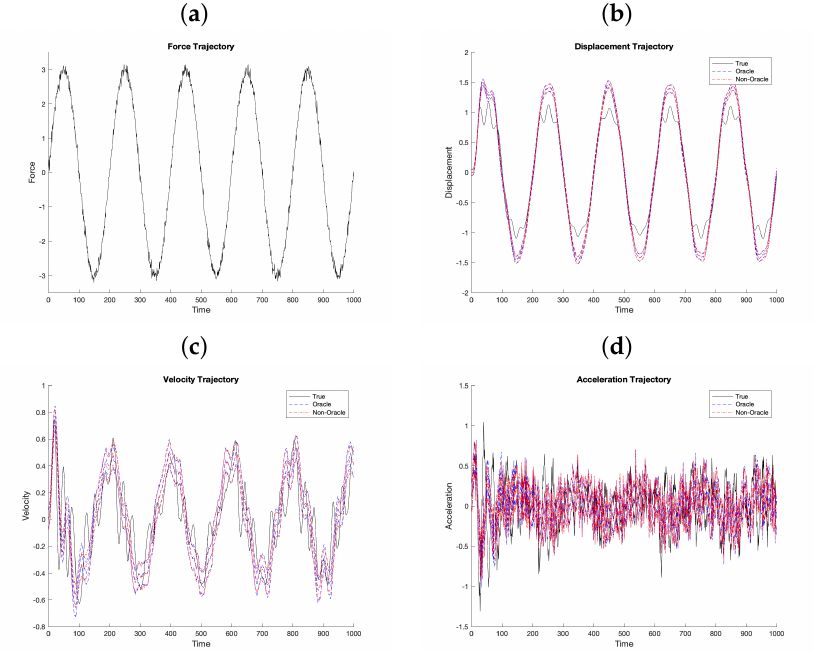
Figure 4. Training Force Contaminated with internal error ( a ) Displacement ( b ), Velocity ( c ) and Acceleration ( d ) trajectories. The Displacement, Velocity, and Accelerations have 95% posterior predictive intervals as well.